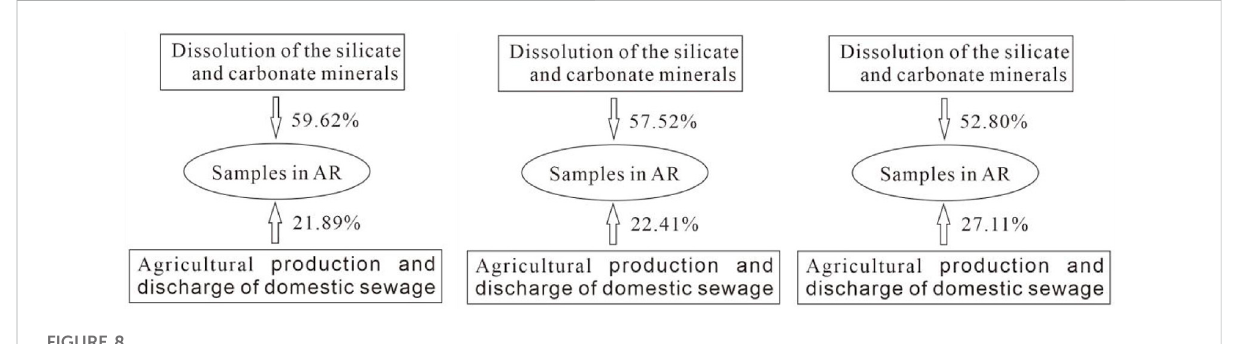
FIGURE 8 Factors dominating the chemical characteristics of river water in the